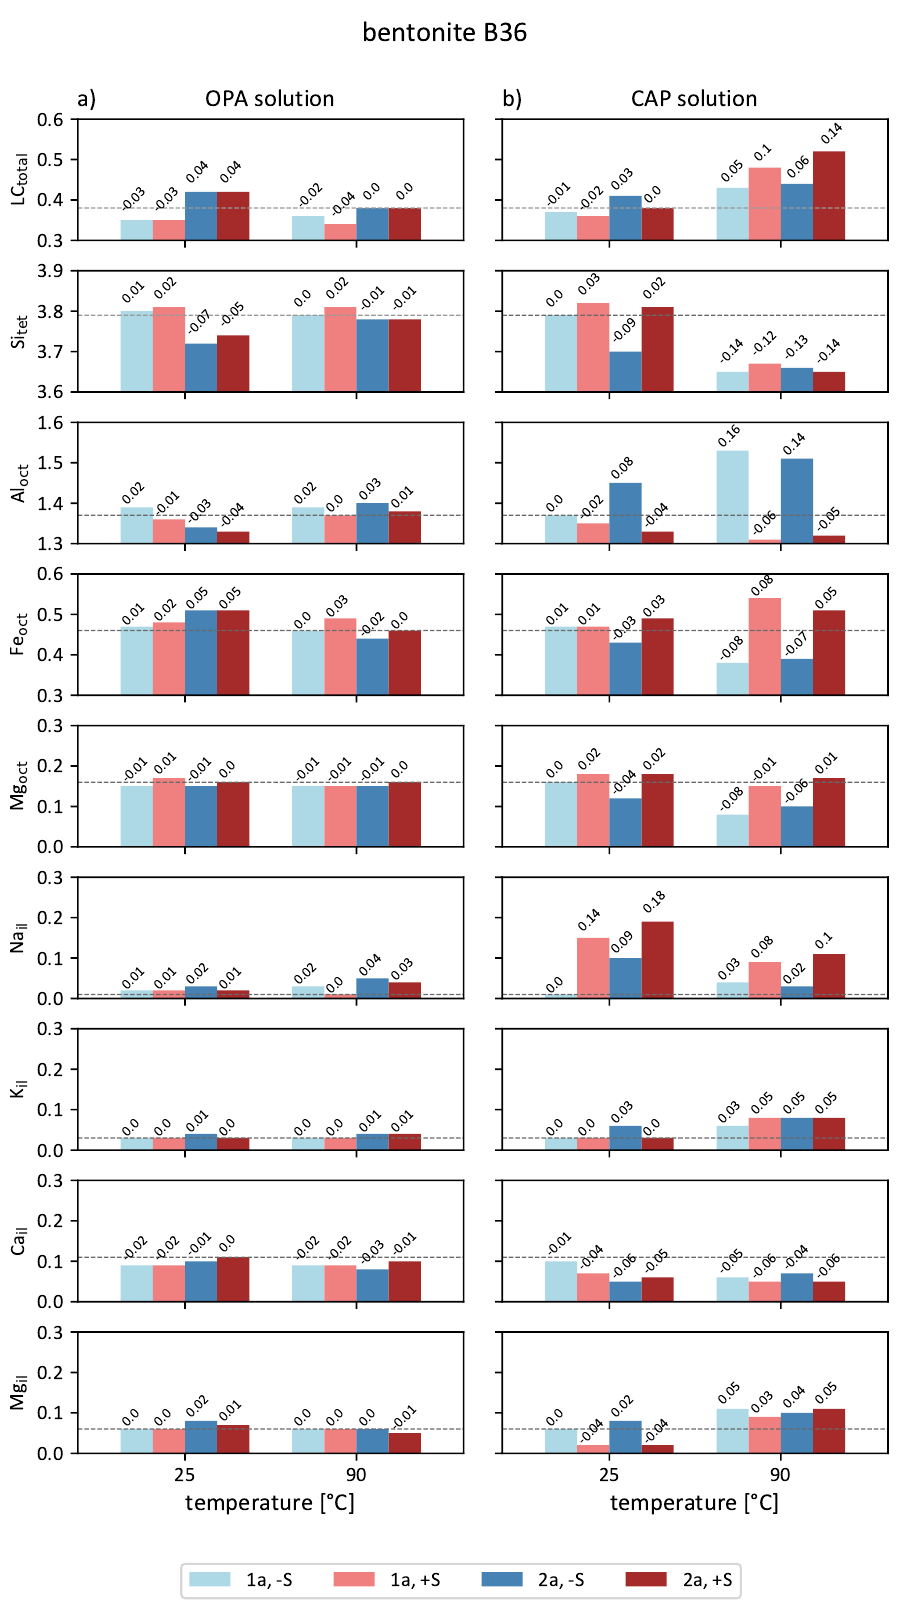
Figure 8. Layer charge and cation distribution of B36 batch experiments with ( a ) OPA solution and with ( b ) CAP solution; tet: tetrahedral sheet, oct: octahedral sheet, il: interlayer. Values above the bars are displaying the rounded deviation (in e · phuc − 1 ) from the initial sample (dotted